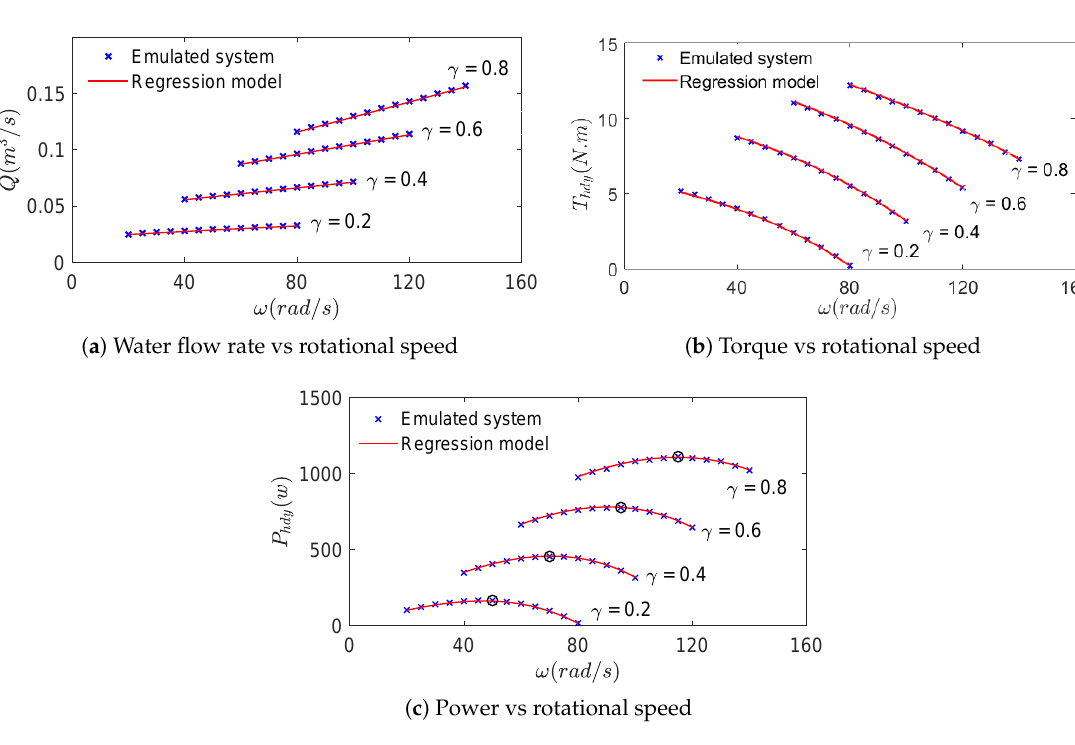
Figure 12. Static hydraulic features assessment, ( a ) water flow rate vs rotational speed, ( b ) hydraulic turbine torque vs rotational speed, and ( c ) output hydraulic power vs rotational